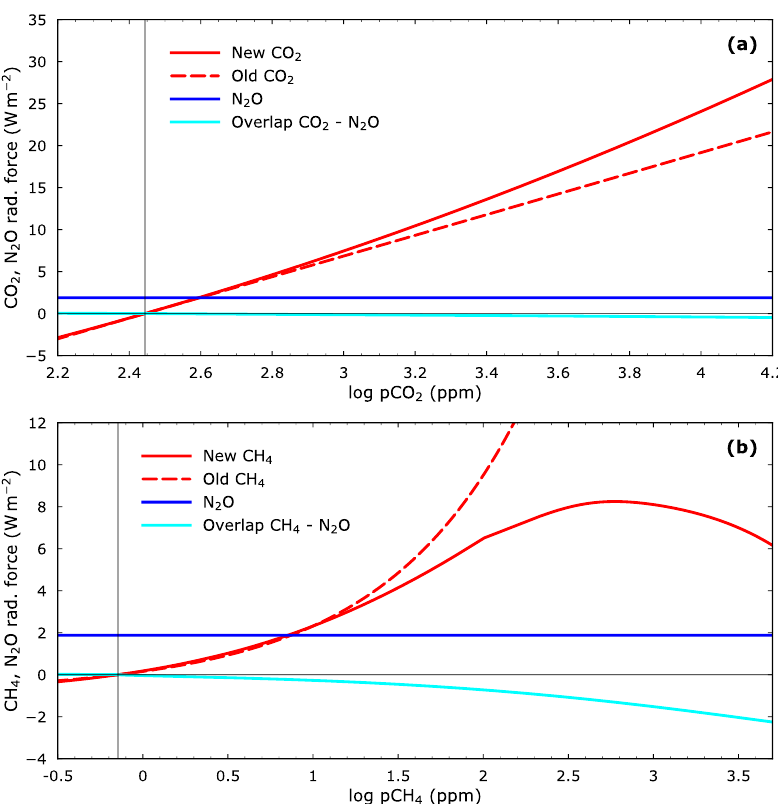
Figure 5. Radiative forcing of carbon dioxide, methane and nitrous oxide as functions of their atmospheric concentrations. (a) CO 2 radiative forcing used here (new CO 2 ; Byrne and Goldblatt, 2014a) compared to CO 2 forcing in the original DCESS model (old CO 2 ; Shaffer et al., 2008). CO 2 –N 2 O overlap (Byrne and Goldblatt, 2014a) and N 2 O radiative forcing calculated for constant, pre-industrial N 2 O partial pressure of 270ppb. (b) CH 4 radiative forcing used here (new CH 4 ; Byrne and Goldblatt, 2014a, b) compared to CH 4 forcing in the original DCESS model (old CH 4 ). CH 4 –N 2 O overlap (Byrne and Goldblatt, 2014a) and N 2 O radiative forcing calculated for constant N 2 O partial pressure as in (a)